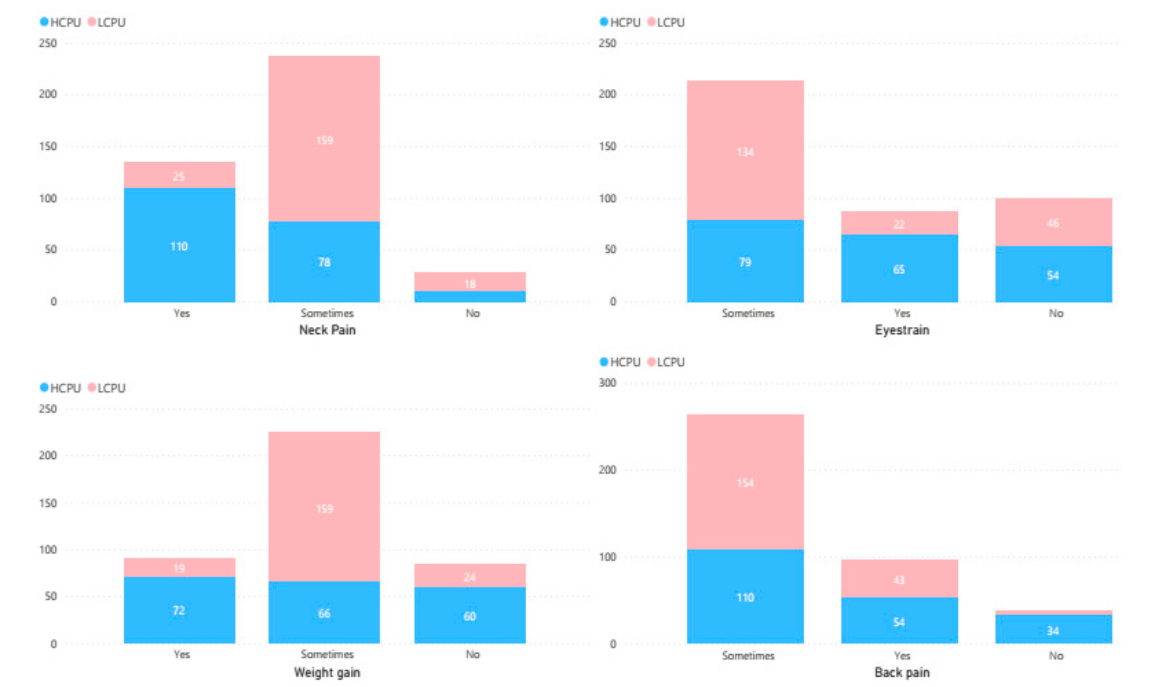
Figure 1. Proportion of neck pain, eye strain, weight gain and back pain based on LCPU and HCPU. HCPU group felt more depressed when compared to the LCPU group ( χ 2 = 74.713, p = 0.000). Loneliness was also found associated with cell phone use but loneliness was found more in the LCPU group as compared to the HCPU group ( χ 2 = 16.935, p = 0.003). Mood disorder was also observed in the HCPU group of the respondents as compared to the LCPU group with a significant association ( χ 2 = 147.318, p = 0.001). Figure 2 shows and HCPU. Table 2. Comparison of the proportions between two groups (LCPU and HCPU).